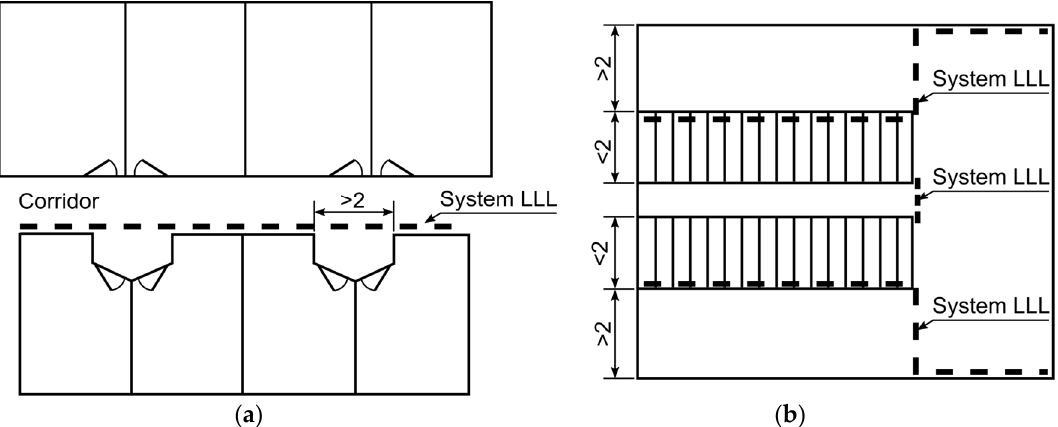
Figure 1. Photoluminescent stripe location as required by ISO 15370:2010 [2]: ( a ) Corridor with recesses wider than 2 m; ( b ) Stairway wider than 2 m.